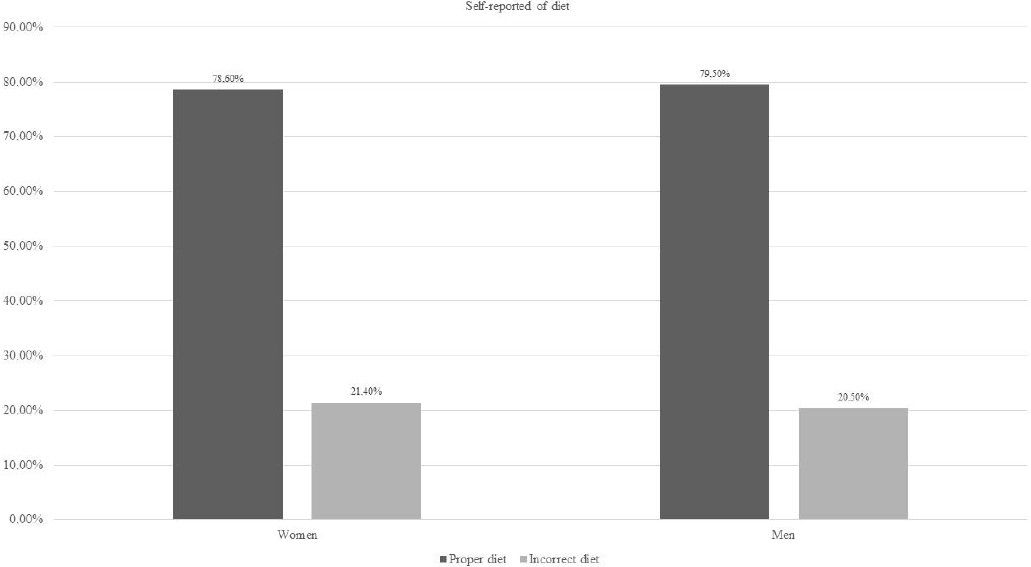
Figure 2. Self-reported diet in the study group of patients by gender (n = 67).